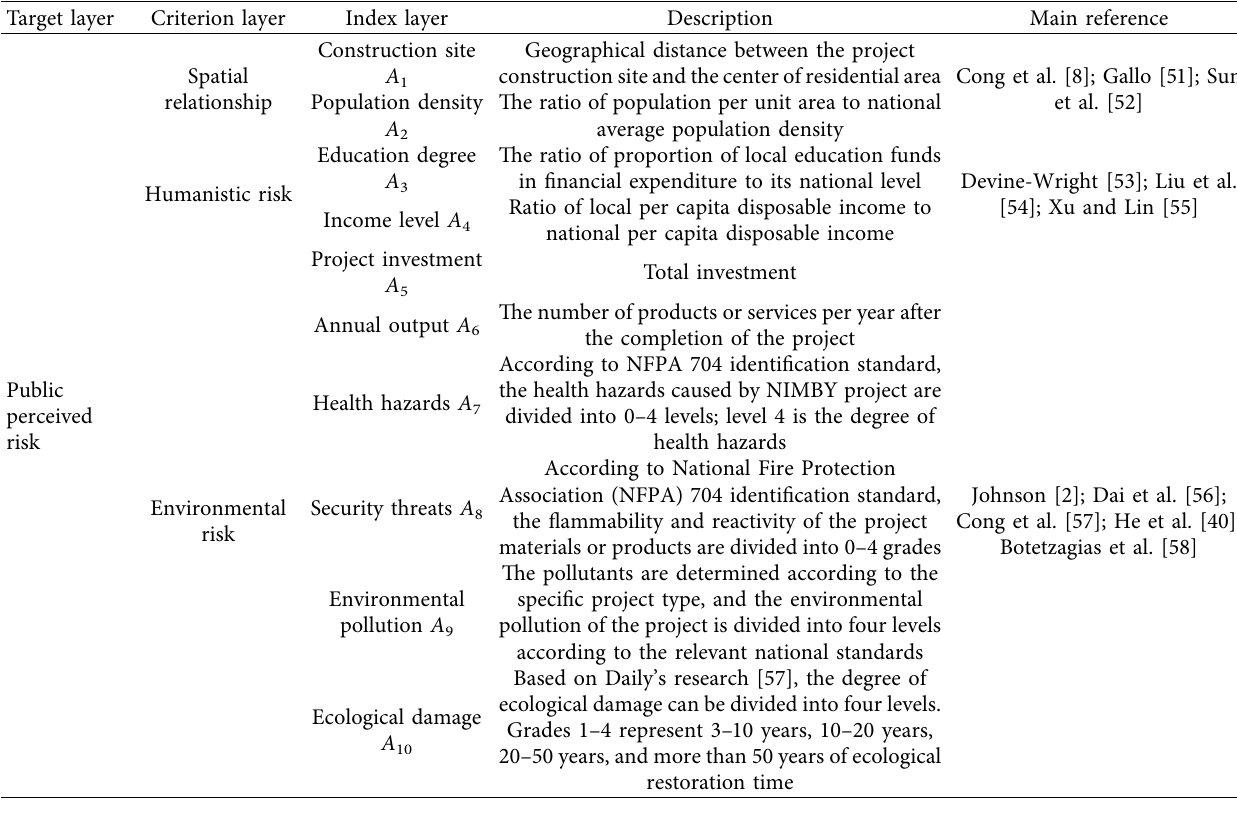
Table 1: Indicators of public risk